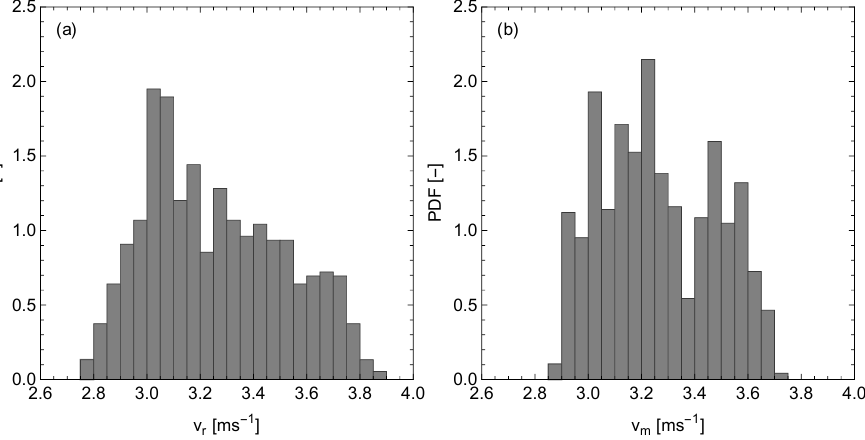
Figure 14. Estimated values of the blade speed based on ( a ) the lidar measurements 𝑣 𝑟 and ( b ) the modelled 𝑣 𝑚 values of Equation (7) using a varying rotational speed of the wind turbine’s